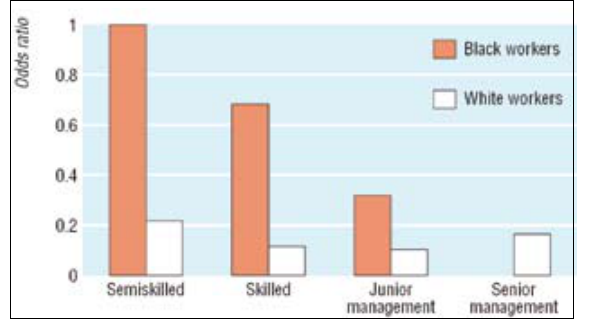
Fig. 1. Odds ratios for HIV prevalence among employees in South Africa.